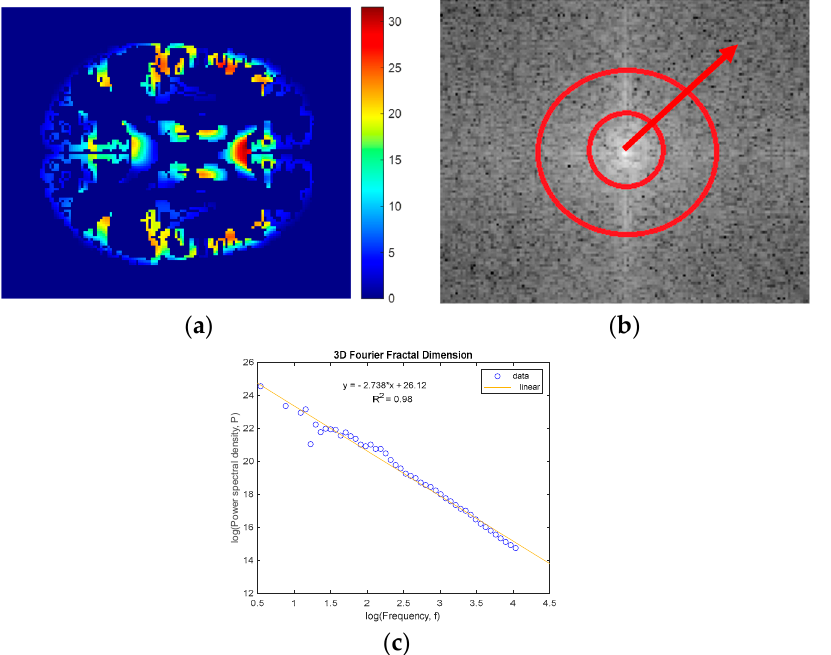
Figure 3. Illustration of 3D Fourier fractal dimension applied on MRI images. Note that for simplicity, only a cross − section of the MRI is shown. ( a ) Step 1: Convert the MRI image into the frequency domain using fast Fourier transform, ( b ) Step 2: Sample the power spectrum radially starting from the centre, and ( c ) Step 3: Estimate FFD based on the slope of the least − squares − fit of the log − log relationship.